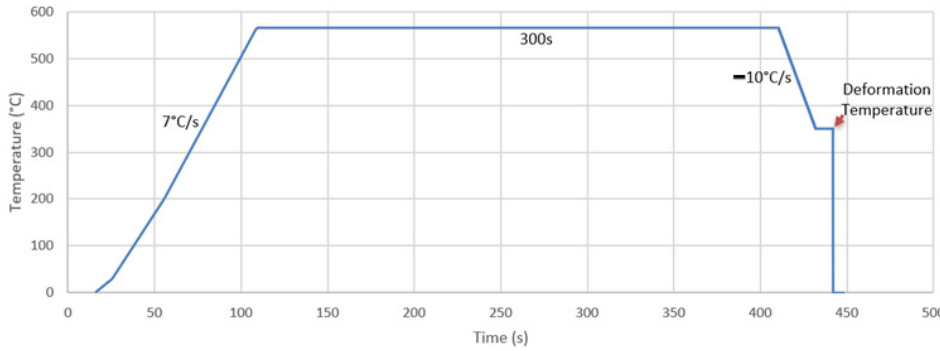
Figure 2. Thermal profile used during testing.